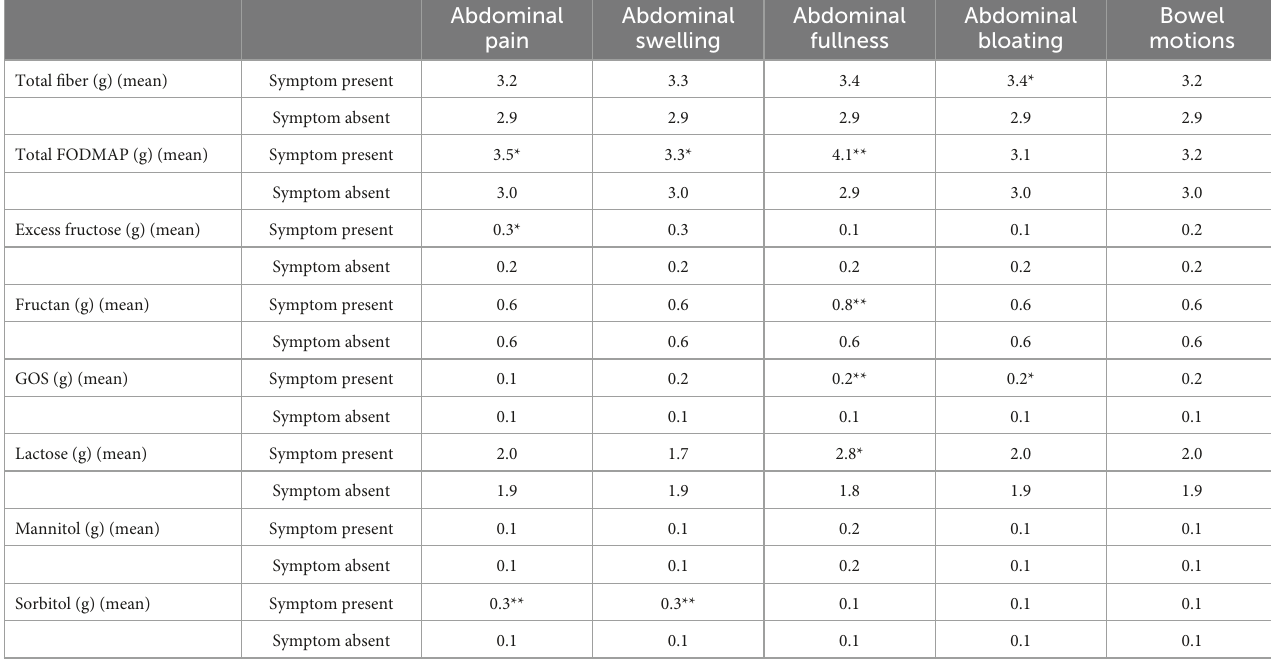
TABLE 4 Average meal fiber and fermentable oligosaccharide, disaccharide, monosaccharide, and polyols (FODMAP) intake according to the presence of post-prandial bowel symptoms in irritable bowel syndrome (IBS) participants.